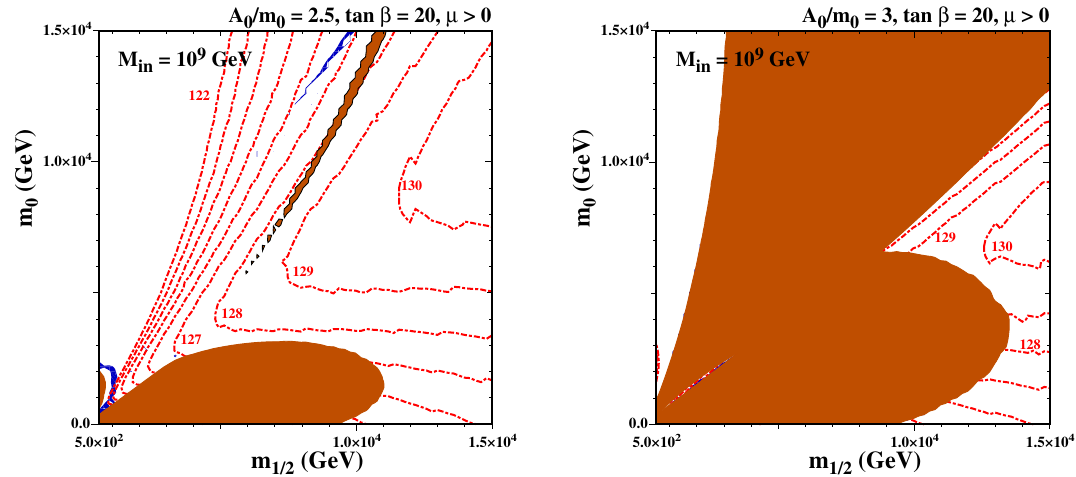
Fig. 10 The ( m 1 / 2 , m 0 ) planes for sub-GUT models with M in = 10 9 GeV, tan β = 20 and for A 0 = 2 . 5 m 0 (left panel) and A 0 = 3 m 0 (right panel). The shadings are the same as in Fig.